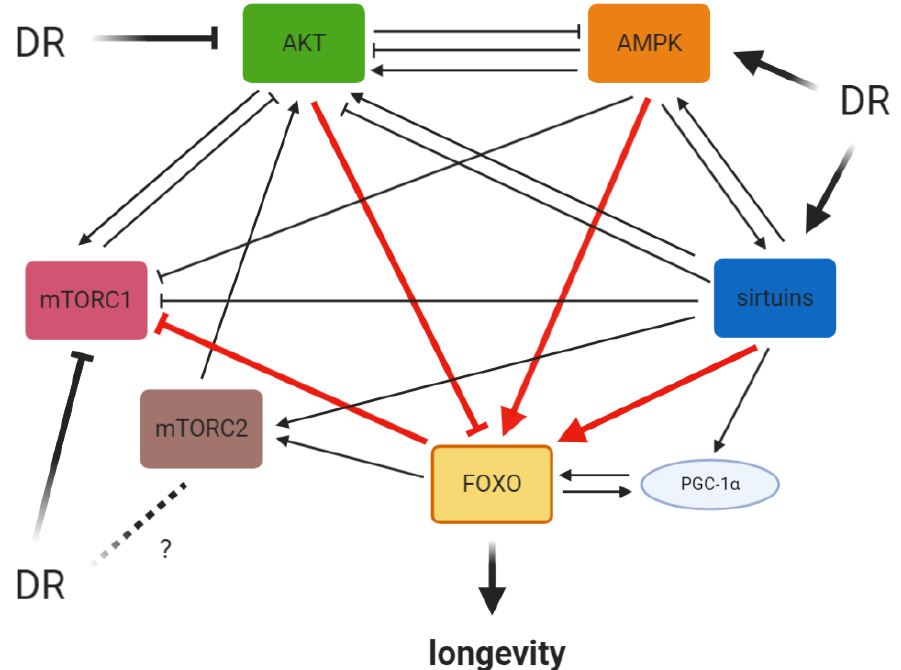
Figure 1. The signaling network of forkhead box O transcription factors (FOXO)-related pathways in dietary restriction (DR).